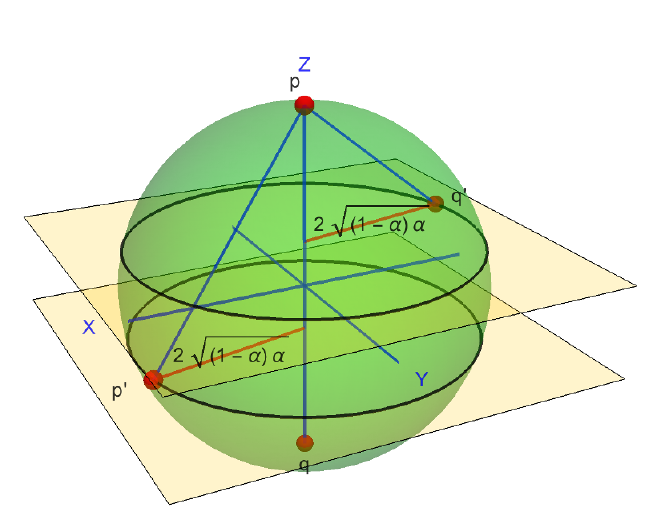
Figure 3 . Punctures on the Riemann sphere for the four particle scattering with momenta p + q (cid:0)! p 0 + q 0 . In the limits (cid:11) ! 0 ; 1 the outgoing punctures collide with the incoming ones located at the